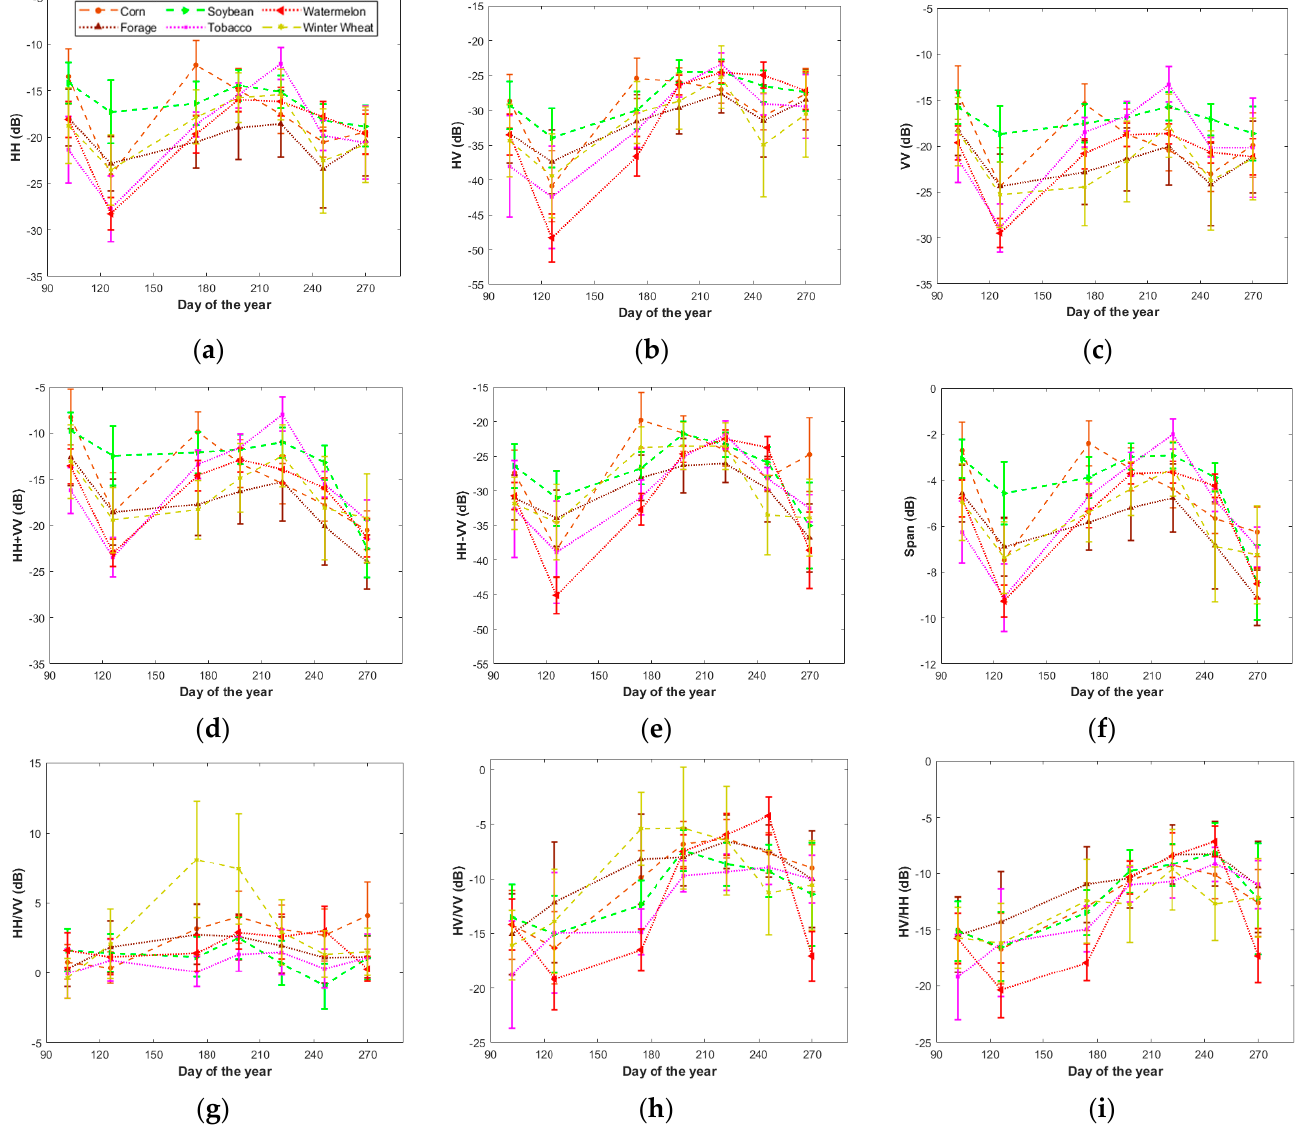
Figure 5. Temporal evolutions in synthetic aperture radar (SAR) backscattering. ( a ) HH; ( b ) HV; ( c ) VV; ( d ) HH + VV; ( e ) HH-VV; ( f ) Span; ( g ) HH/VV; ( h ) HV/VV; ( i ) HV/HH. Note error bars denote standard deviation.